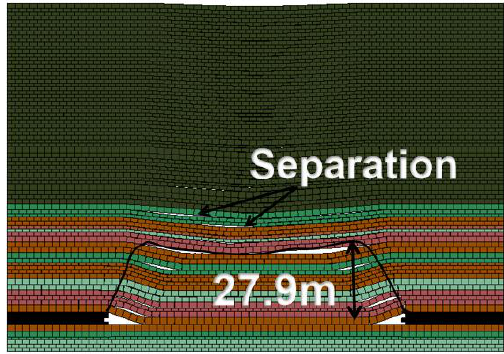
Figure 8. Collapsed shape of thick bedrock.